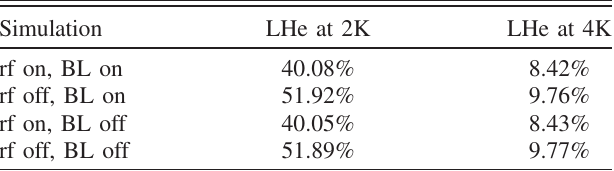
TABLE III. Summary of fraction of particles surviving 10 turns after a quench of the KEKB-like cavity under different